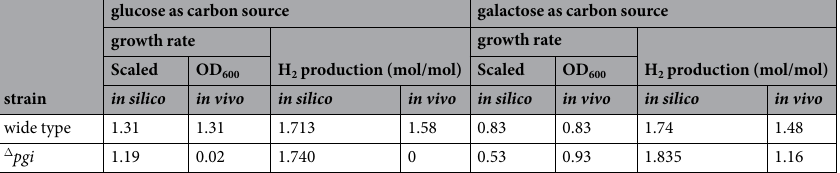
H 2 production (mol/mol)